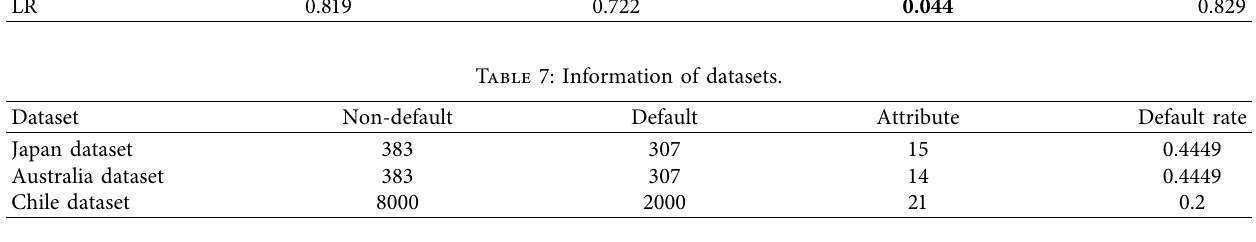
Table 8: The rank of four models on different